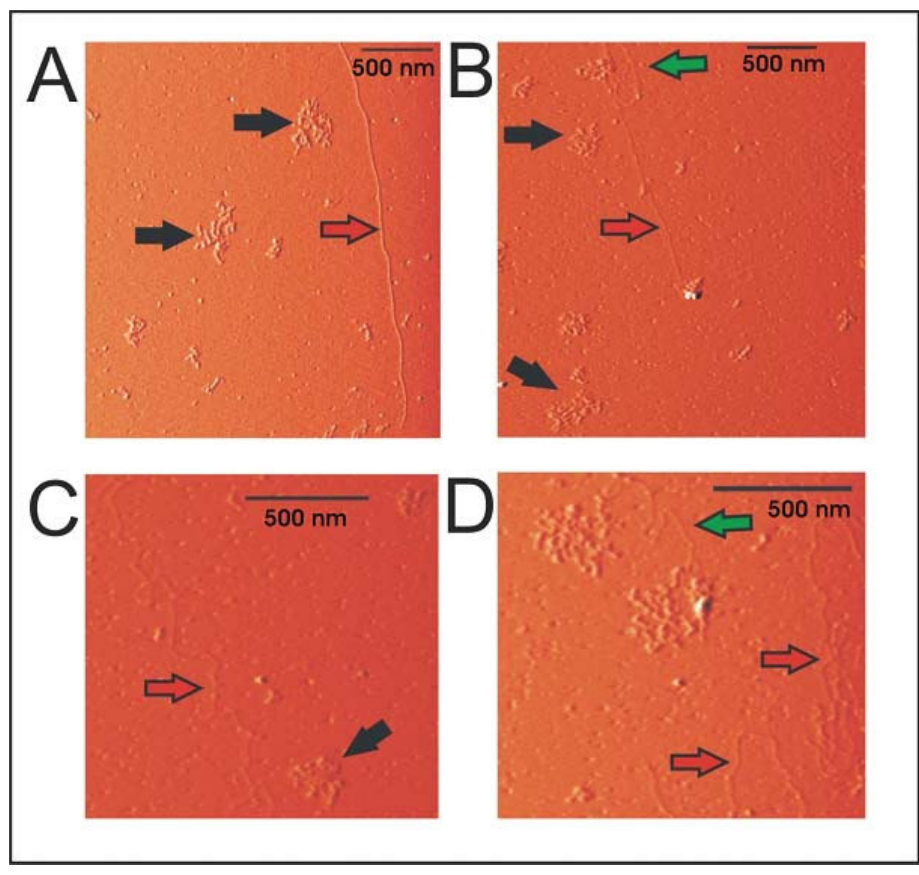
FIGURE 2. Noncontact tapping mode AFM of DNA obtained from the vegetative forms of M. gallisepticum S6 in air. (A–D) 2D images recorded from the different areas of scanning. The black arrow, the DNA molecules fold into compact shapes; green arrow, DNA in hemicompact form; red arrow, DNA in unstressed